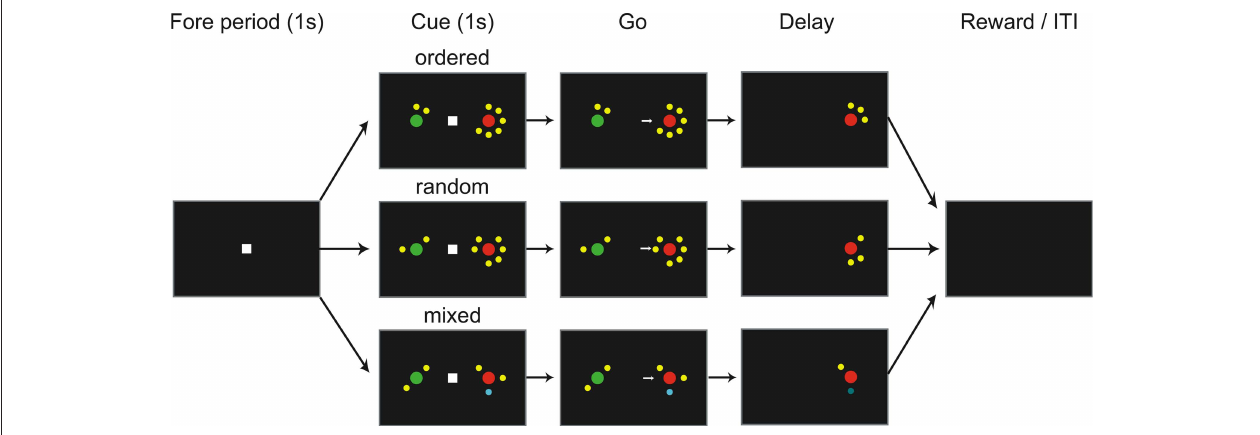
FIGURE 1 | Spatiotemporal sequences of the inter-temporal choice task. Three different types of clocks are referred to as ordered, random, and mixed. For both ordered and random clocks, the reward delay was indicated by the